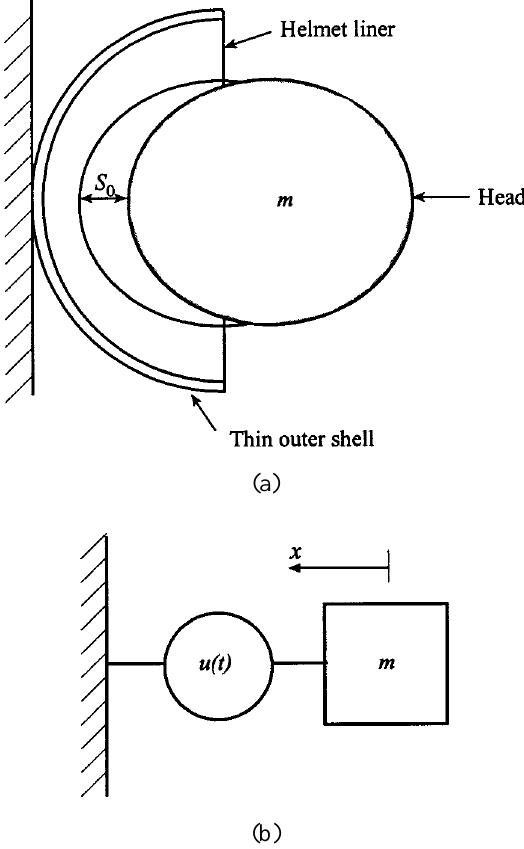
Fig. 1. Helmeted head under impact using SDOF model: (a) Illustra- tion of the problem, (b) Physical model for the limiting performance analysis. Fig. 2. Translation head injury